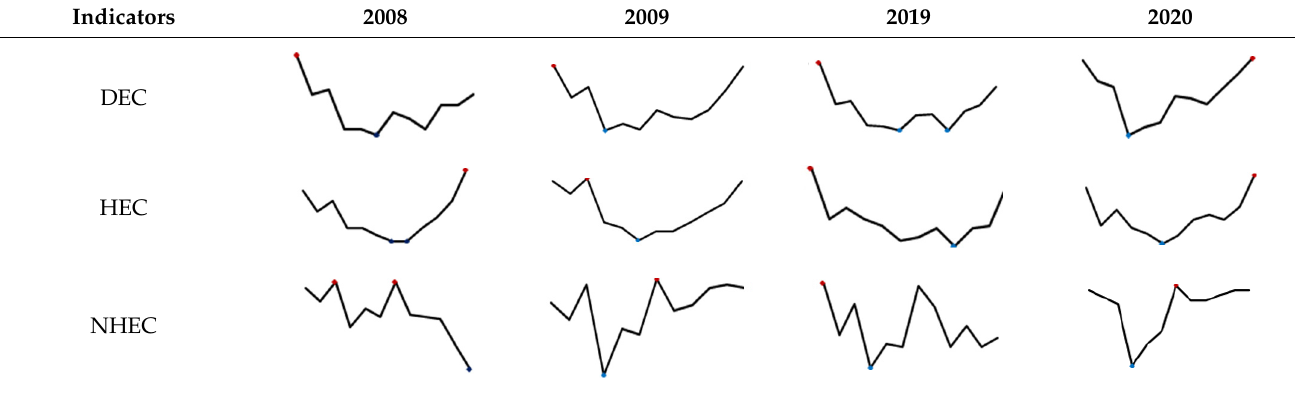
Table 2. The monthly evolution of electricity consumption in the years 2008, 2009, 2019, and 2020. Indicators